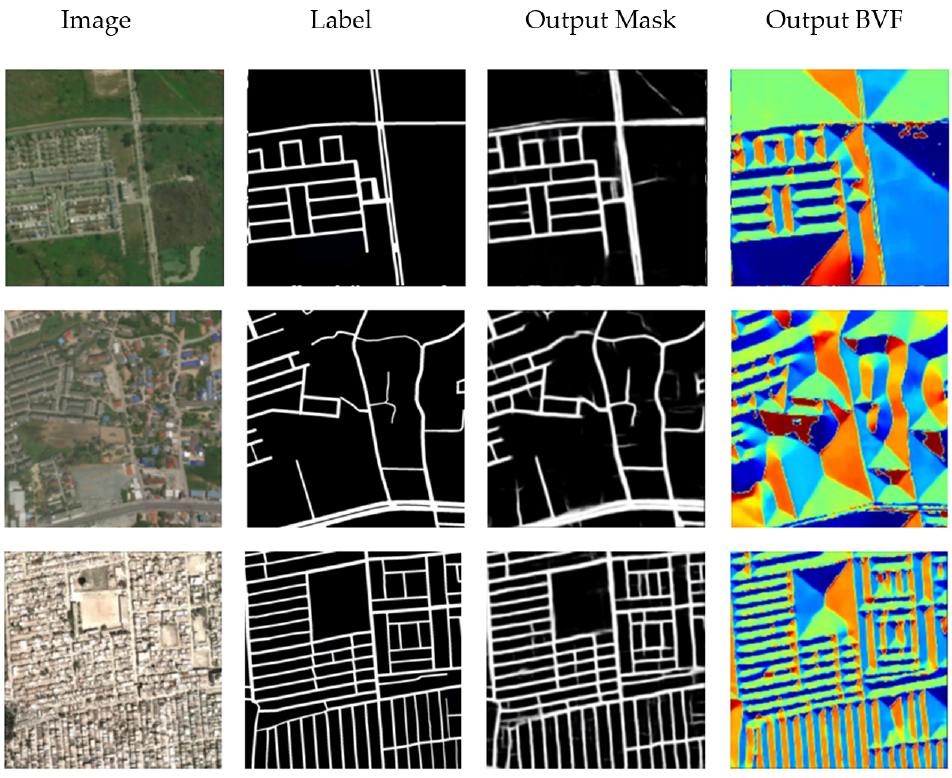
Figure 9. Road Extraction Results Using Mask and BVF Learning. Table 4. The performance evaluation of road extraction using mask learning and BVF.